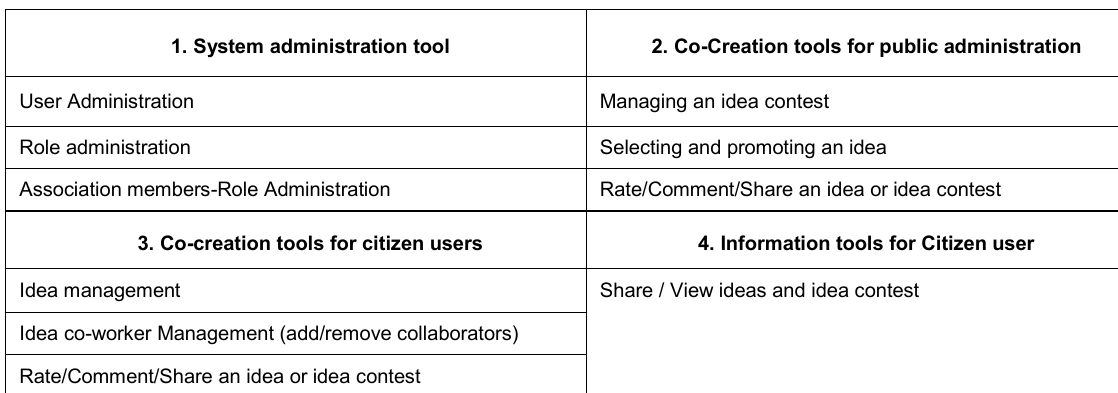
Table 2. IMS main